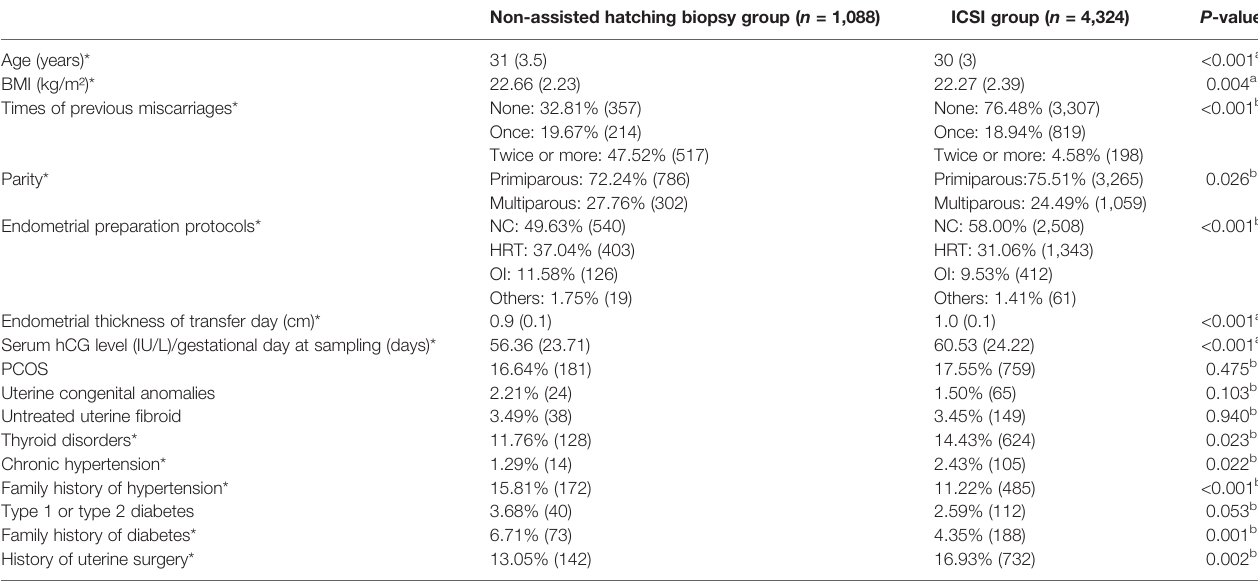
TABLE 1 | Comparisons of demographic characteristics between the non-assisted hatching biopsy group and the ICSI group. Non-assisted hatching biopsy group ( n =